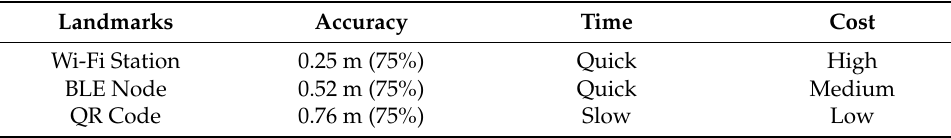
Table 1. Performance comparison of landmark detection approaches.